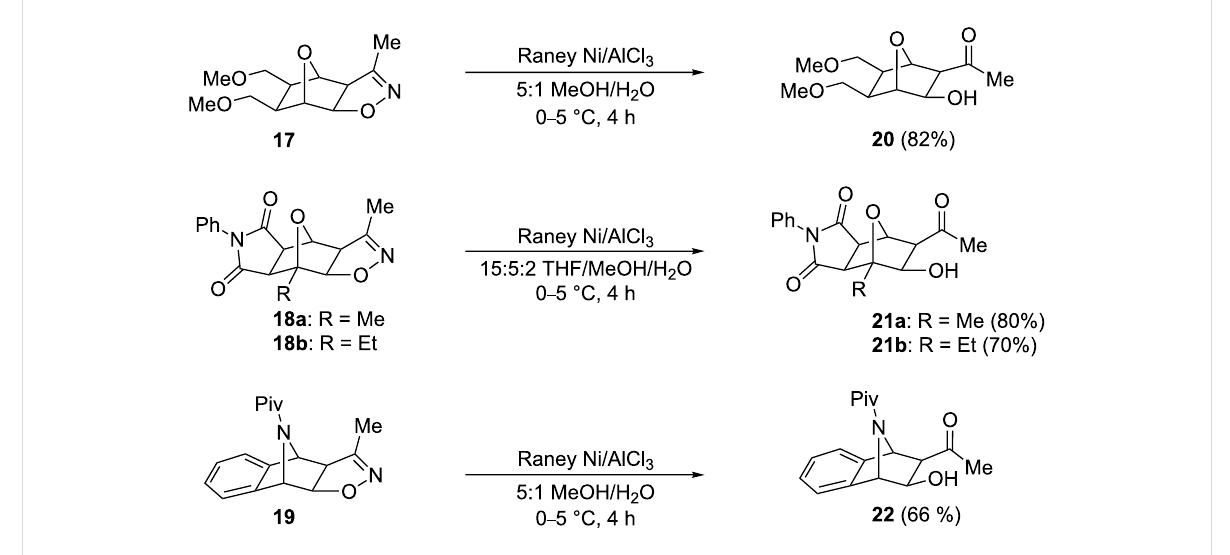
Scheme 3: Raney Ni/AlCl 3 -mediated cleavage of 2-isoxazolines with various fused heterobicyclic